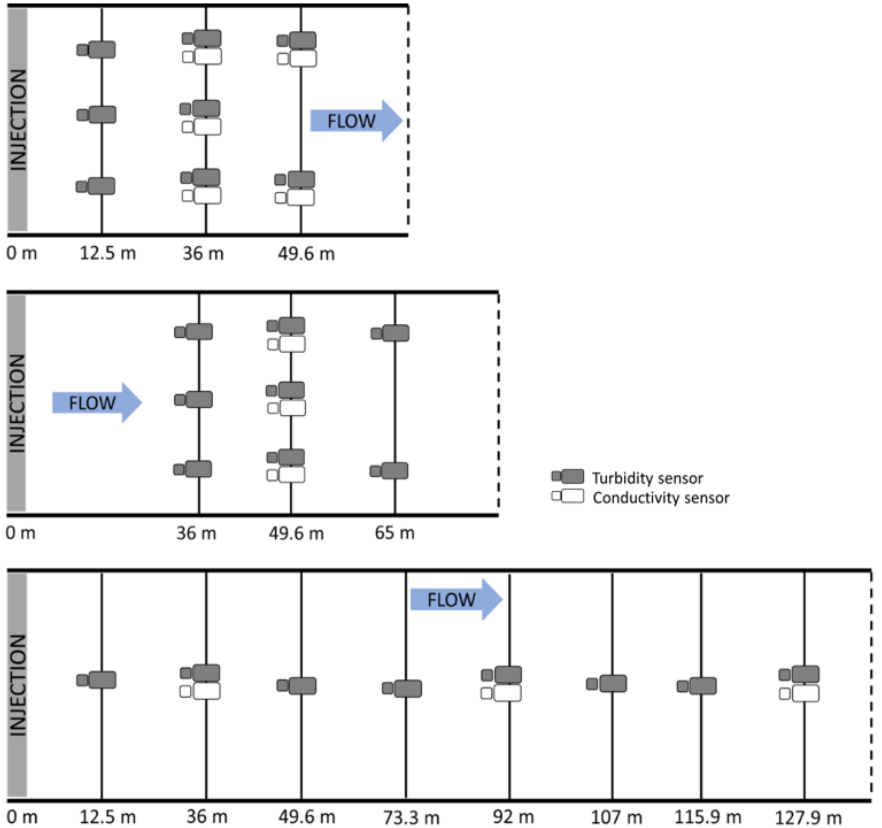
Figure 5. Instrument deployment configurations used in multiple experiments in the natural channel.